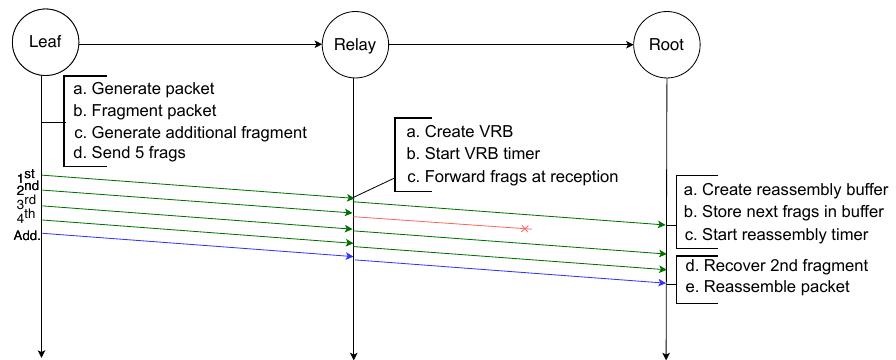
Figure 9. Successful transmission of a fragmented packet with XORFEC: even though one fragment is lost it is recovered thanks to the additional